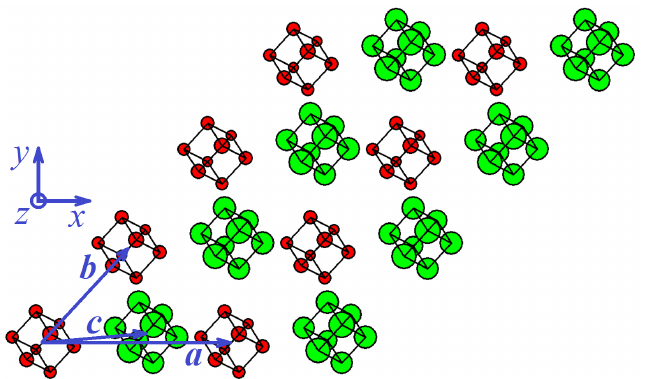
Figure 3. Structure of triclinic cubene. The larger the z coordinate, the larger circle shows the carbon atom. Red (green) color is used for the lower (upper) plane of the structure (only two planes of cubenes are shown). Vectors of the primitive translation cell, a , b , and c , are given by Equation (10). A primitive translational cell includes one cubene; therefore, all cubenes have the same orientation in space.